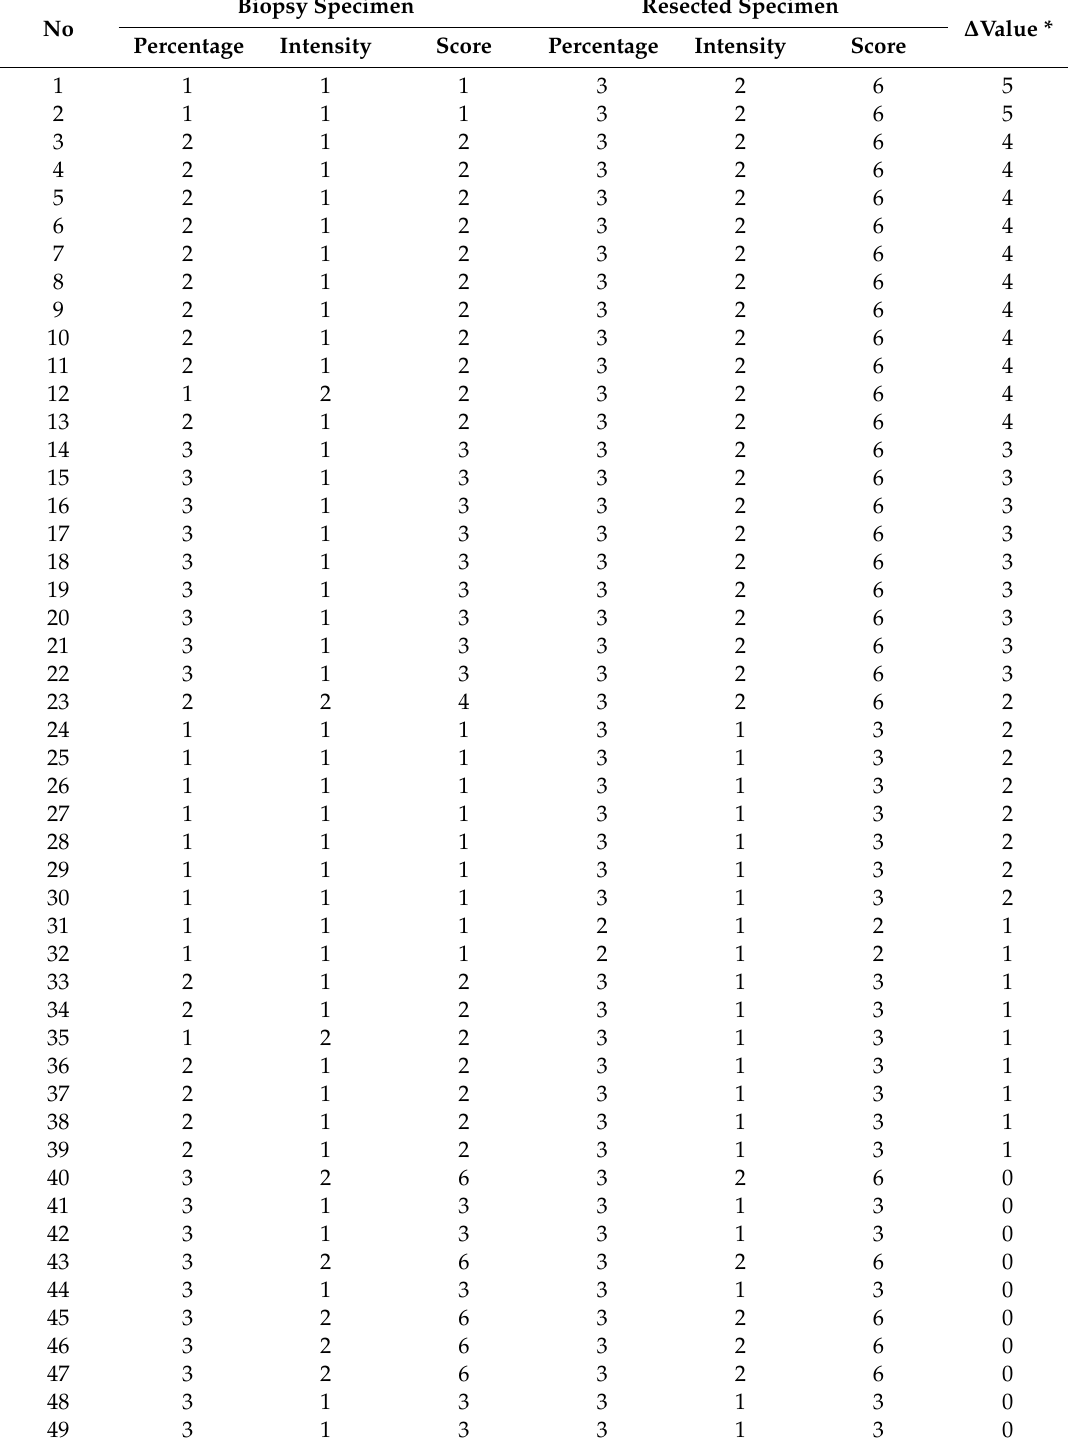
Table 2. FBXW7 staining scores in pre-treatment biopsy specimens and post-treatment resected specimens for each